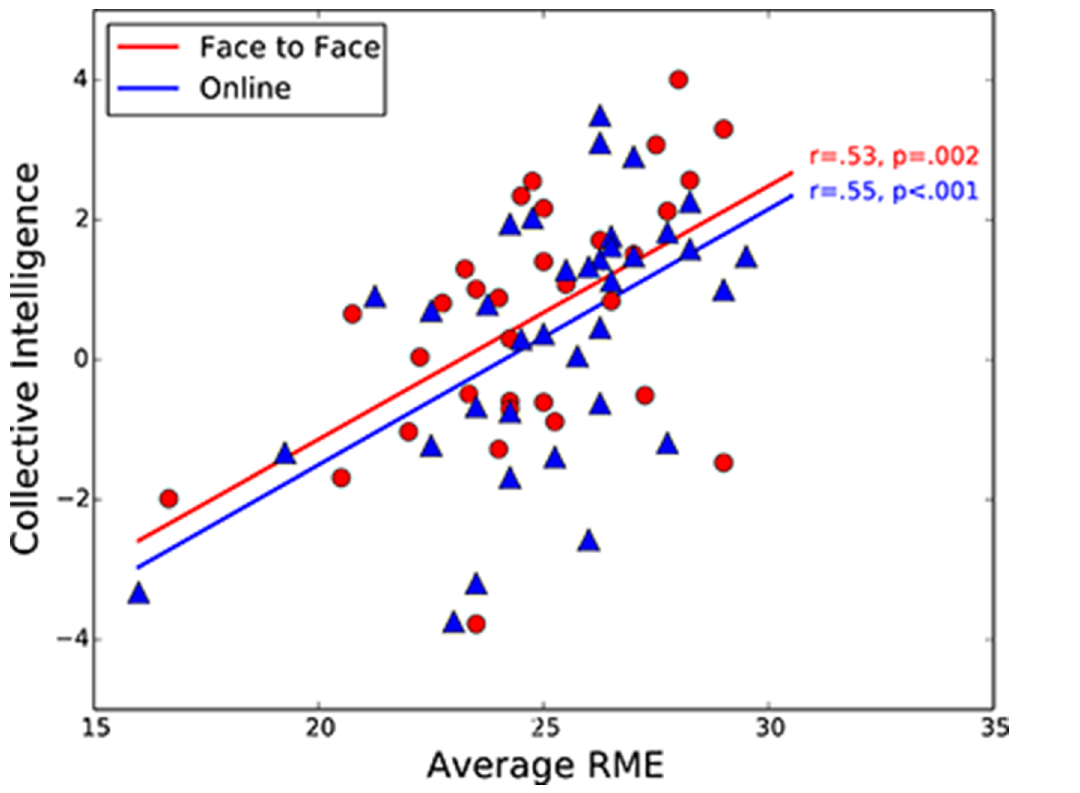
Fig. 3. Relationship between average group RME and collective intelligence scores for face to-face (N 5 32) and online (N 5 36) groups. The correlations are significant and almost identical for both groups. Similar results are obtained when the two potential outlier groups with the lowest average RME scores are removed (r 5 .47, p , 0.01 and r 5 .48, p , 0.01 for face-to-face and online groups,